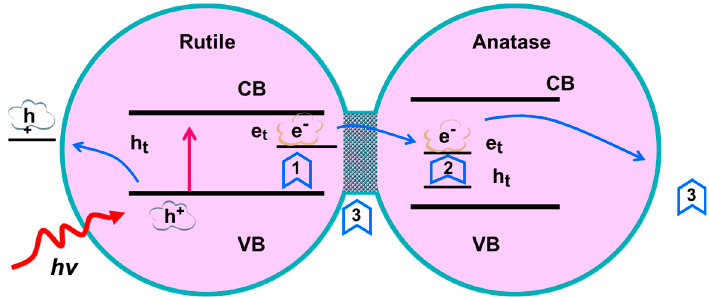
Figure 6. Conceptual model of mixed phases TiO 2 catalysts: (1) the rutile lattice, (2) the anatase lattice, and (3) interfacial and surface sites.